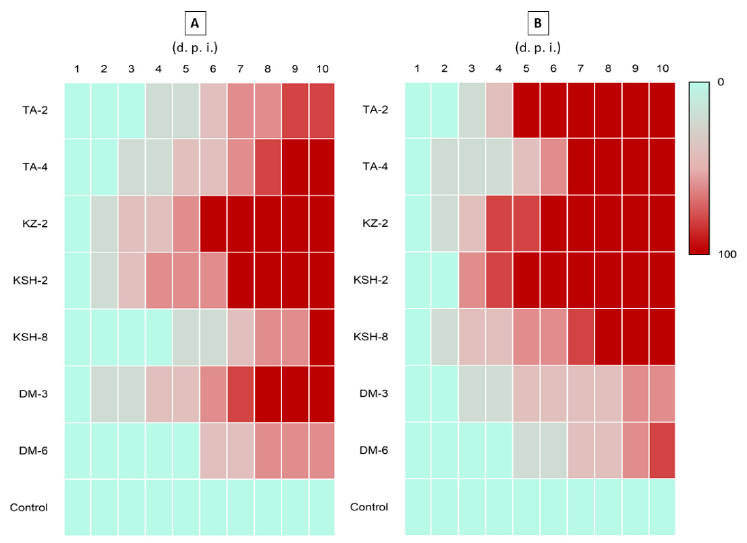
Figure 4. Insect killing heatmap of seven selected entomopathogenic fungal isolates belonging to three genera isolated from different regions in Nile Delta against S. litura ( A ) and T. molitor ( B ).